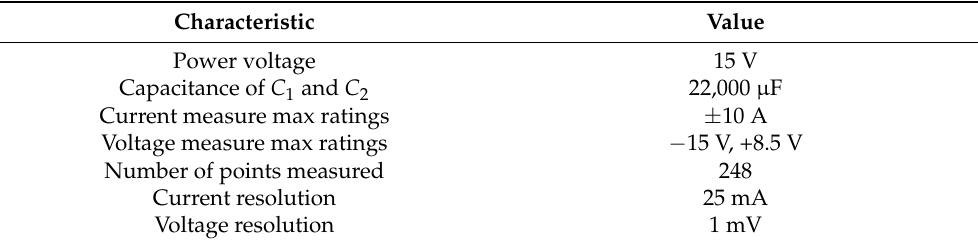
Figure 17. Prototype implementation of the proposed device. Table 2. Technical characteristics of the device produced.